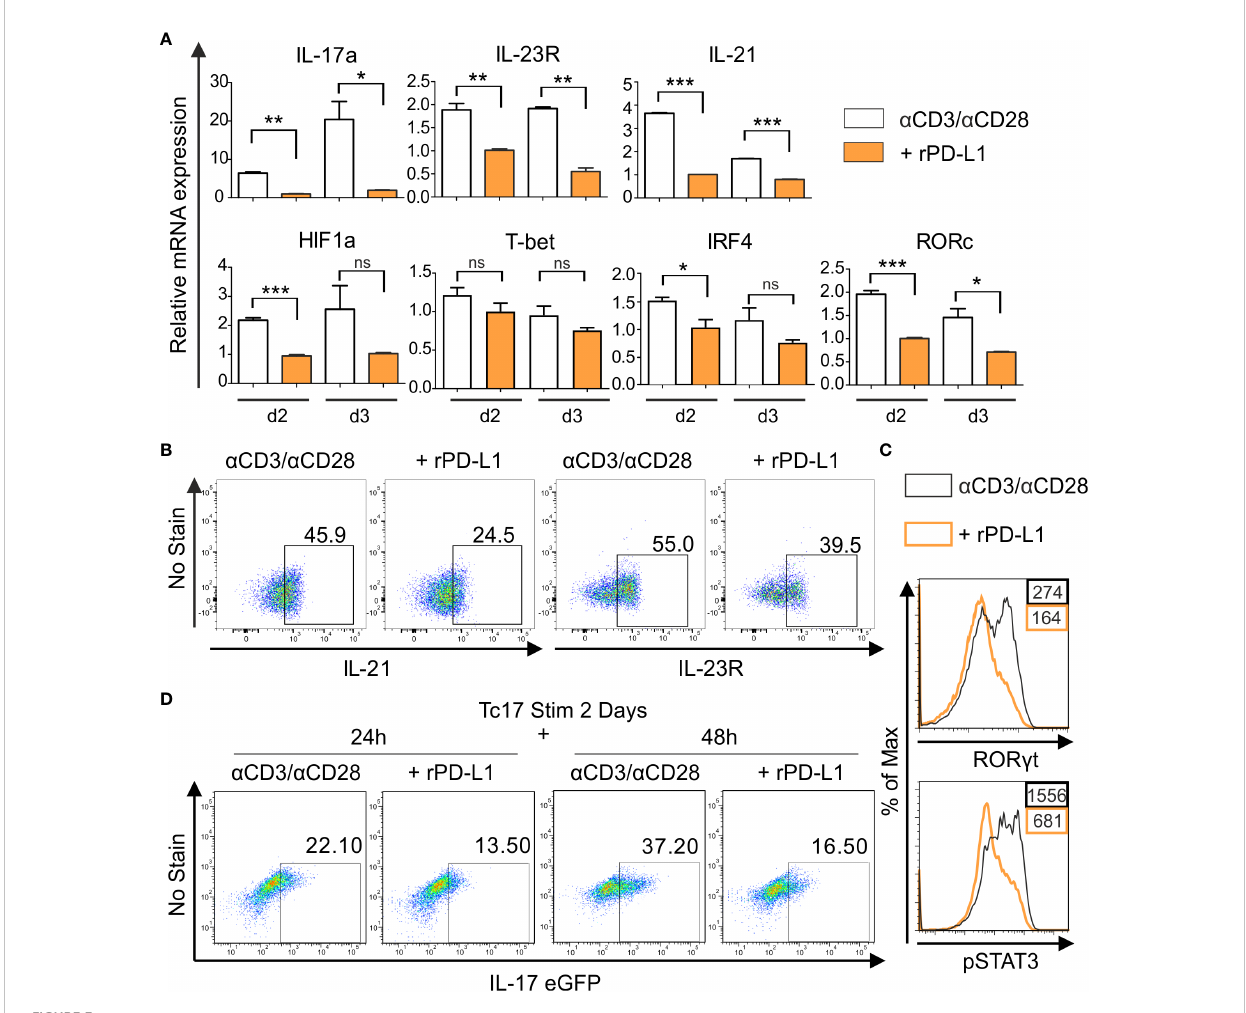
FIGURE 3 PD-1 suppresses Tc17 hallmarks. (A) CD8 + T-cells from C57BL/6 mice were stimulated as in (2C) and harvested at indicated time points. The harvested cells were lysed, RNA was extracted, and RT was used to synthesize cDNA. The relative expression levels of the indicated genes analyzed using real-time PCR are shown as mean+SEM of replicates from an experiment. (B, C) Tc17 cells were stimulated as in (A) and expression of IL-21 and IL-23R (B) , ROR g t and pSTAT3 (C) was measured by fl ow cytometry 3 days after activation. (D) CD8 + T-cells from IL-17A-eGFP reporter mice were stimulated with microspheres immobilized with anti-CD3, anti-CD28 for 2 days under Tc17 conditions. These cells were then engaged with microspheres immobilized with rPD-L1 or not, associated with anti-CD3 and anti-CD28 for indicated time points and thereafter IL-17 expression was measured by fl ow cytometry. The data is representative of two to three independent experiments. *** P <0.001, ** P <0.01, * P <0.05; ns, not signi fi cant, calculated by unpaired t-